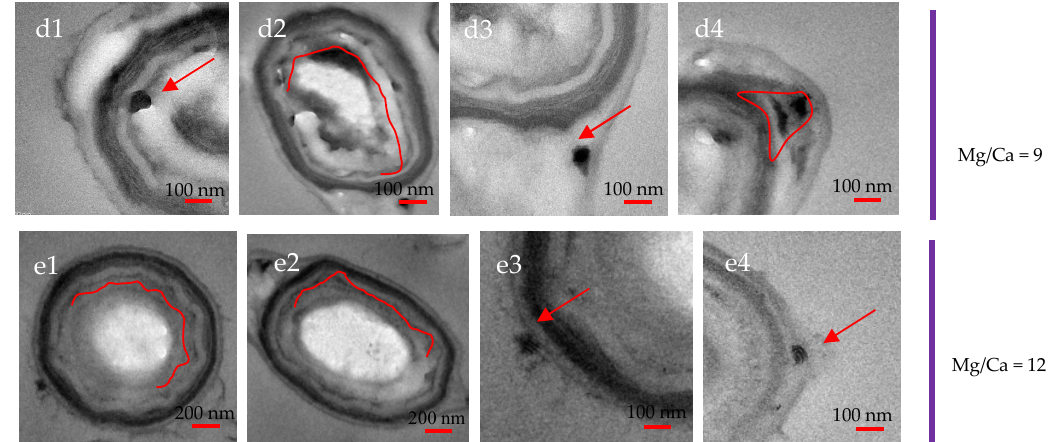
Figure 9. TEM analyses of ultrathin slices of B. licheniformis cultivated for 24 d. The intracellular and extracellular granules are marked with red arrows. Mg/Ca molar ratio of 0 ( a 1 – a 4 ): intracellular granules ( a 1 , a 2 ) and extracellular granules ( a 3 , a 4 ); Mg/Ca molar ratio of 3 ( b 1 – b 4 ): intracellular granules ( b 1 – b 3 ) and extracellular granules ( b 4 ); Mg/Ca molar ratio of 6 ( c 1 – c 4 ): intracellular granules ( c 1 , c 2 ) and extracellular granules ( c 3 , c 4 ); Mg/Ca molar ratio of 9 ( d 1 – d 4 ): intracellular granules ( d 1 , d 2 ) and extracellular granules ( d 3 , d 4 ); Mg/Ca molar ratio of 12 ( e 1 – e 4 ): intracellular granules ( e 1 , e 2 ) and extracellular granules ( e 3 , e 4 ).